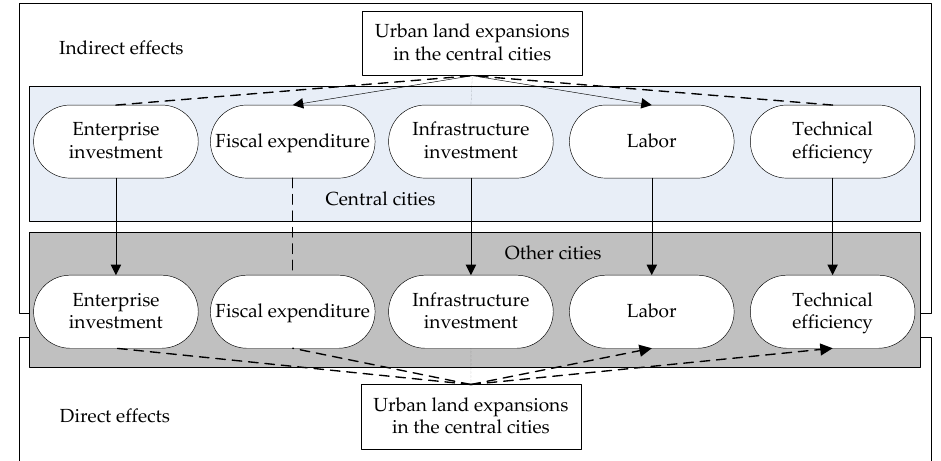
Figure 4. The impacts of urban land expansions on the production factors in urban agglomera- tions.